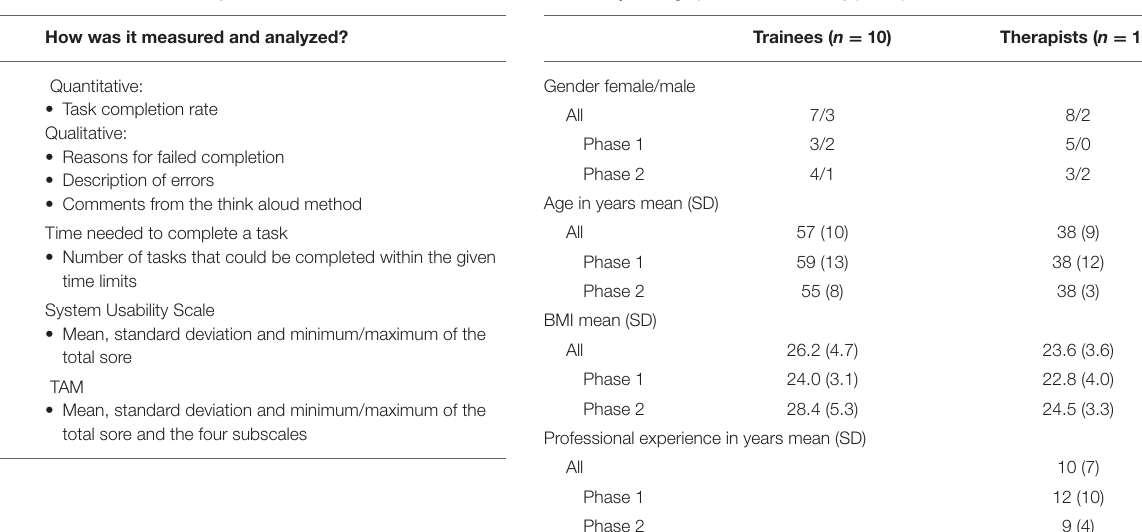
TABLE 4 | Demographic data of usability